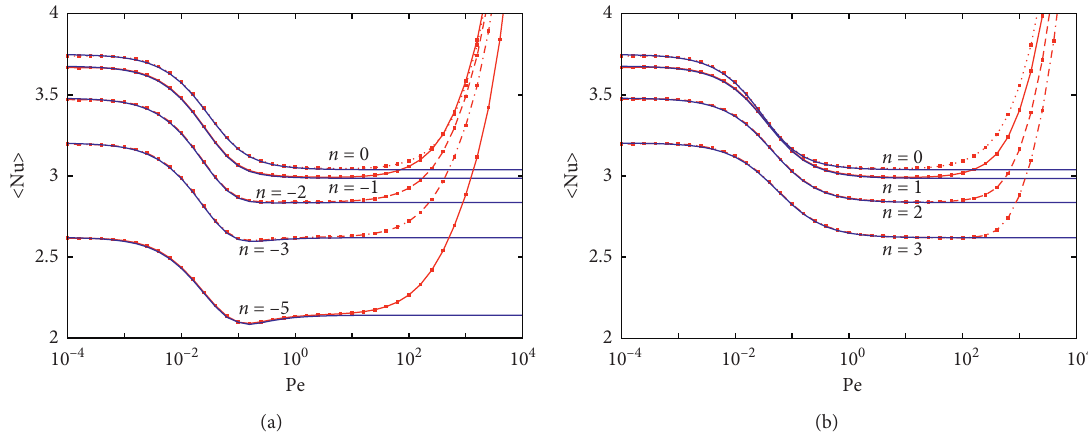
Figure 6: Comparison between numerical (red curves with dots) and analytical results (blue continuous lines) for the average Nusselt 〈 Nu 〉 as a function of Pe for the exponential wall heat flux function q w ( ζ ) � ( ne − n ζ /1 − e − n ) , Br � 0 . 1, Kn � 0 . 0, α � 0 . 02, β + � β − � 2. (a) Constant wall heat flux n � 0 and exponentially increasing wall heat flux n � − 1 , − 2 , − 3 , − 5. (b) Constant wall heat flux n � 0 and ex- ponentially decreasing wall heat flux n � 1 , 2 , 3.